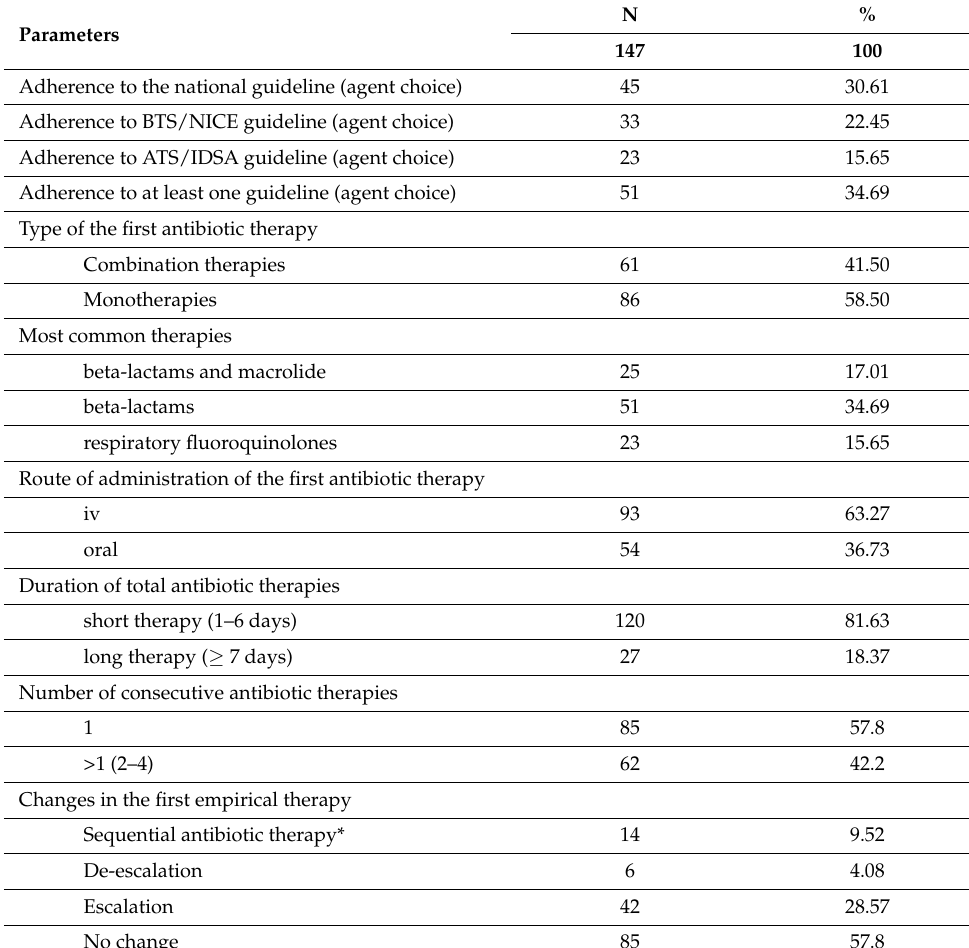
Table 3. Characteristics of antibiotic